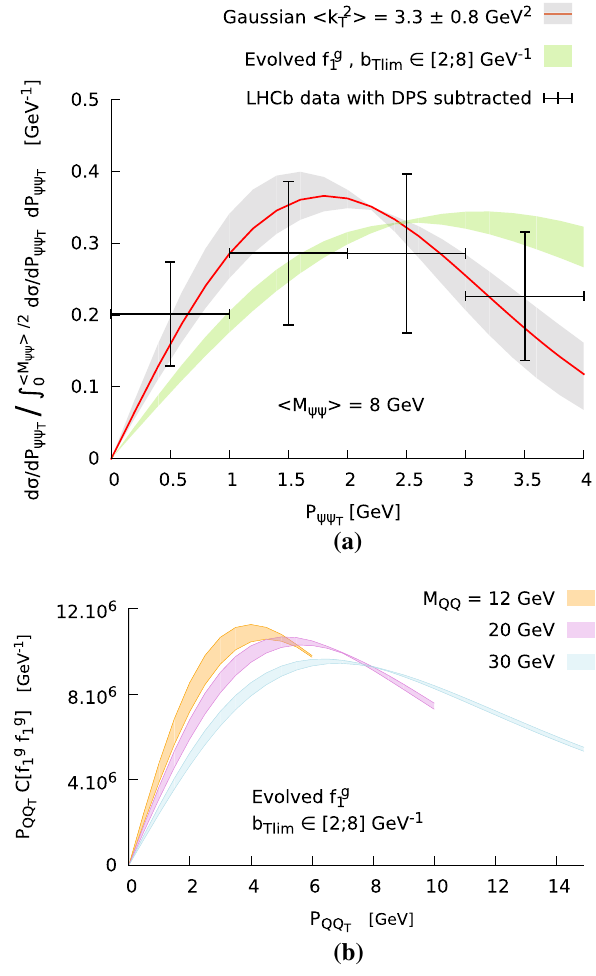
Fig. 3 (a) The normalised P QQ T -spectrum for J /ψ -pair production at M ψψ = 8 GeV using two gluon TMDs. The first is a Gaussian Ansatz (cid:14) = 3 . 3 ± 0 . 8 GeV 2 obtained from the LHCb data [30] (the with (cid:13) k 2 T red curve shows the central value and the gray band the associated uncertainty). The second is the result of our present study with TMD evolution. The green band results from the uncertainty on the b T -width of the nonperturbative Sudakov factor S NP . The estimated DPS contri- bution has been subtracted from the LHCb data (black crosses) which were also normalized over the interval. (b) The P QQ T -spectrum using our evolved gluon TMDs at M QQ = 12, 20 and 30 GeV for the same uncertainty on the b T -width